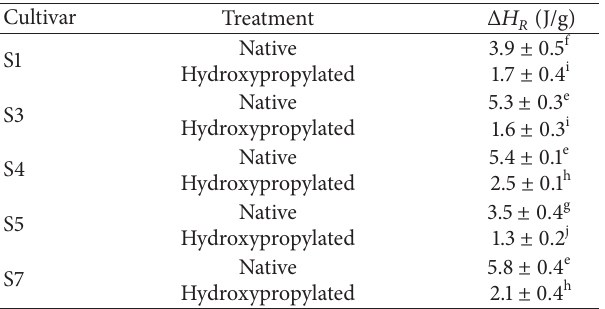
Table 3: Retrogradation a of native and hydroxypropylated sweet potato starch as measured by DSC.